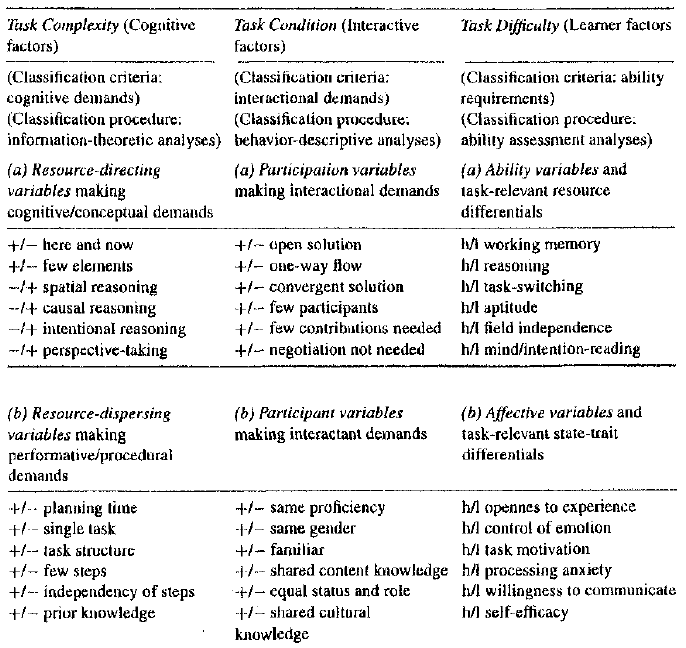
The Triadic Componential Framework for Task